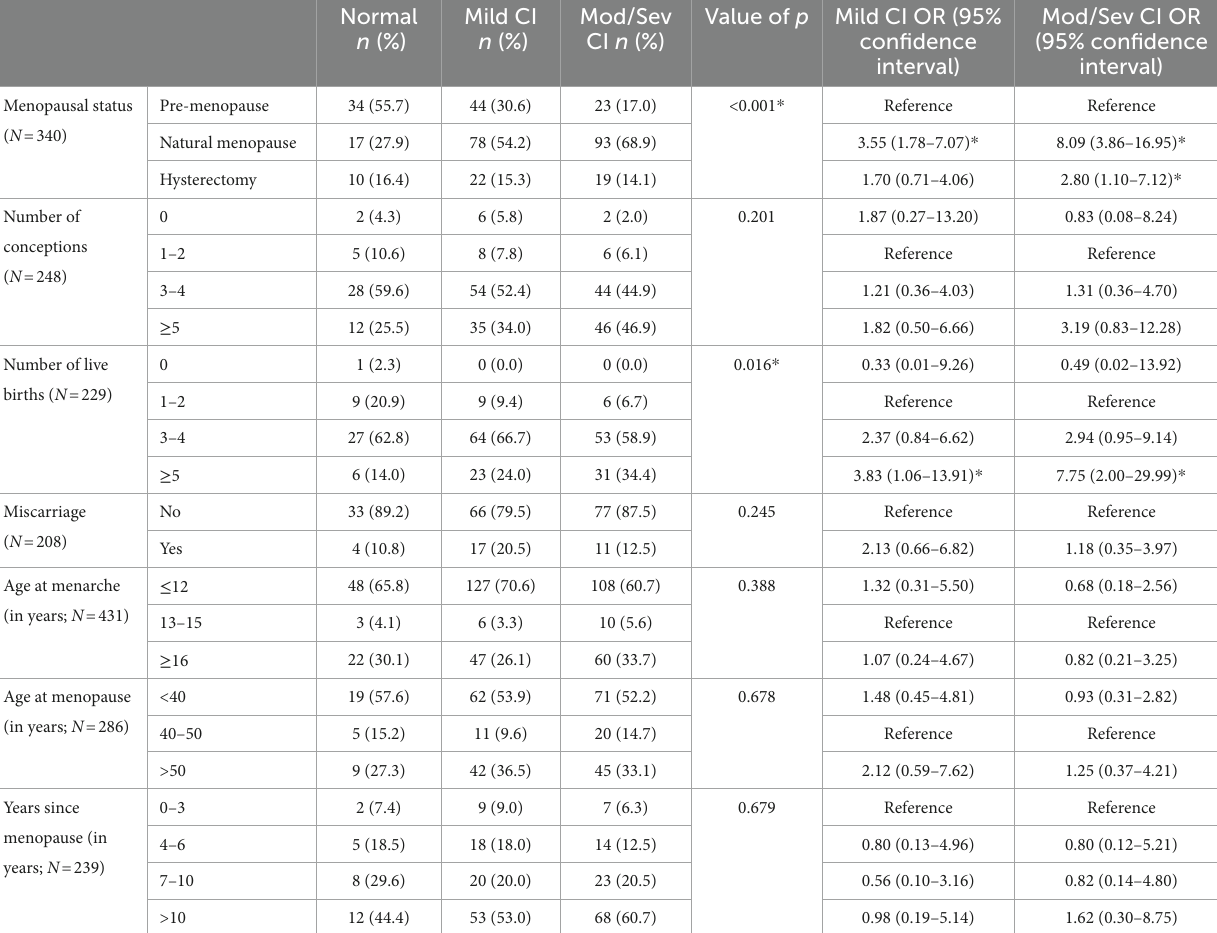
TABLE 6 Relationship between reproductive events and cognitive impairment among women participants.